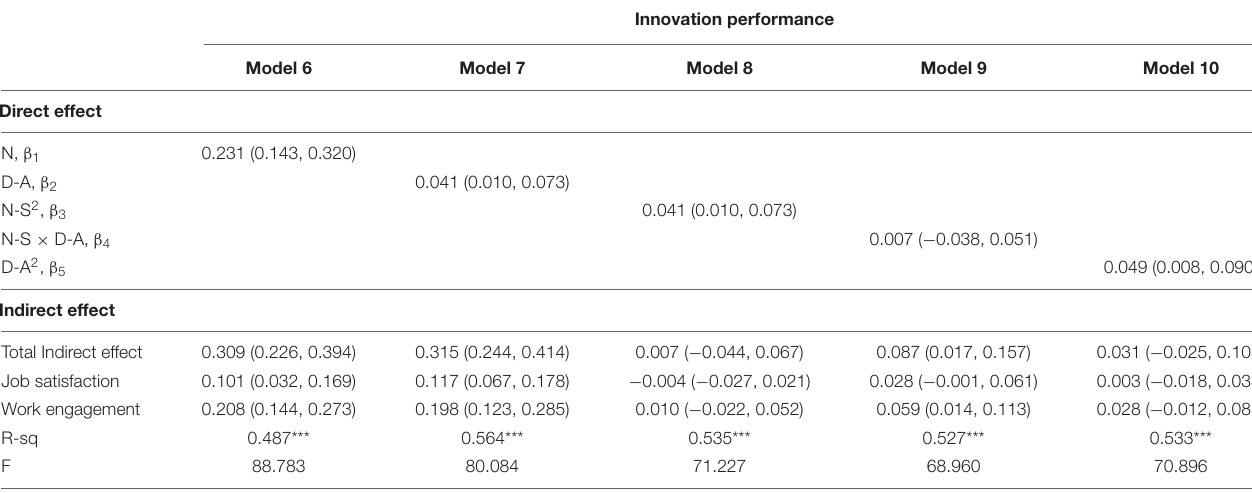
TABLE 5 | Test results of the meditating effect of job satisfaction and work